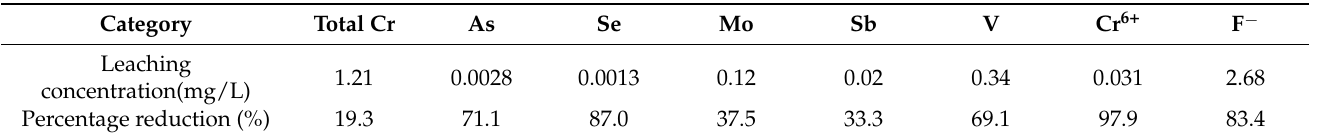
Table 4. Leaching concentration and reduction ratio of some hazardous substances in solidified red mud.